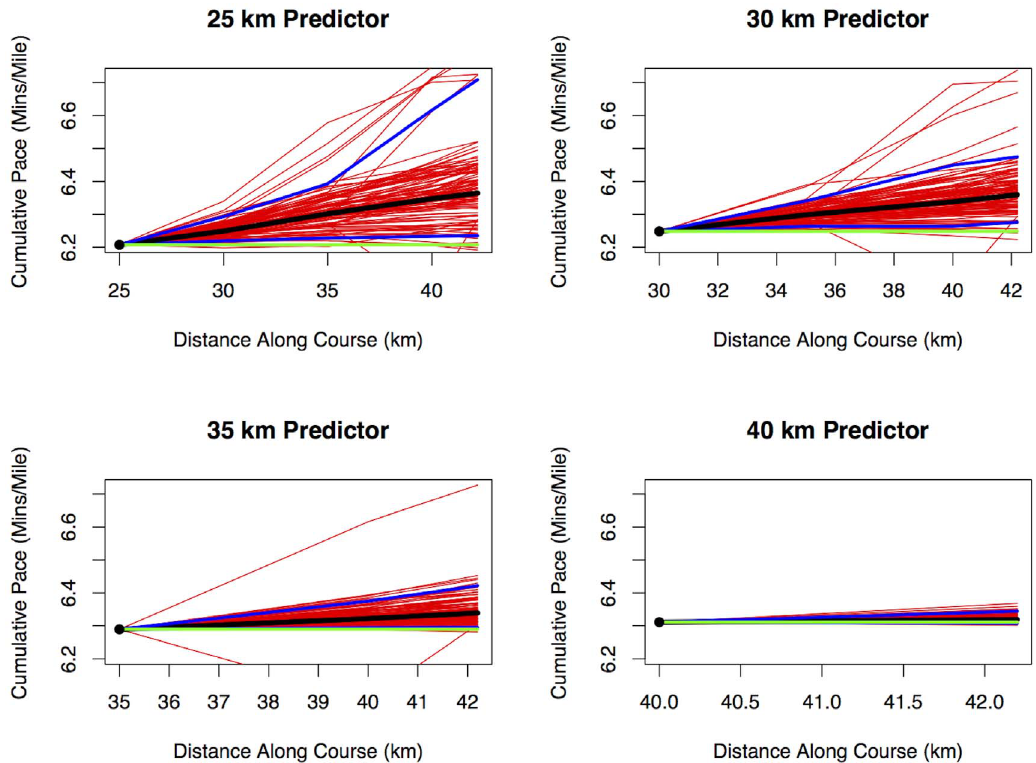
Figure 8. Illustration of Rescaled KNN Method. The figure shows how the method is to predict the pace during the remainder of the race for a runner sampled at the 25 km, 30 km, 35 km or 40 km intermediate time points. The black dot represents distance and net pace of a particular runner at the sampling time. For that runner, we locate the K =100 nearest neighbors among the full population of runners, using all the split times up to the sampling point. These neighbors are rescaled by multiplying/dividing by a constant so that the net pace at the sampling time is the same as the runner being predicted. The 100 runner profiles are then shown for the remainder of the course. The think black line is the median through all the neighbor runners and therefore provides a prediction for the runner of interest. The lower and upper blue lines represent the 5th and 95th percentiles of the distribution — these therefore provide the bounds of a 90% prediction interval for the future pace of the runner of interest. The horizontal green line is the Constant Pace projection. All results are presented as net overall pace (minutes/mile) to facilitate comparisons over the length of the course.